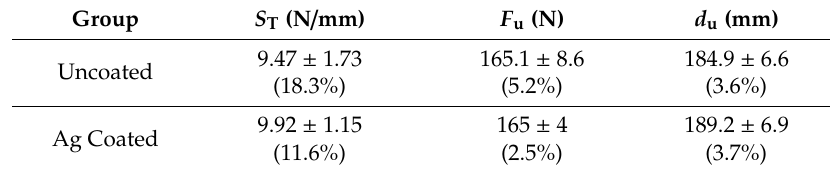
Table 1. Tensile stiffness ( S T ), ultimate force ( F u ) and displacement ( d u ) for each evaluated group (uncoated and coated). The percentage represents the coefficient of variation (CoV%) of the estimated parameters.